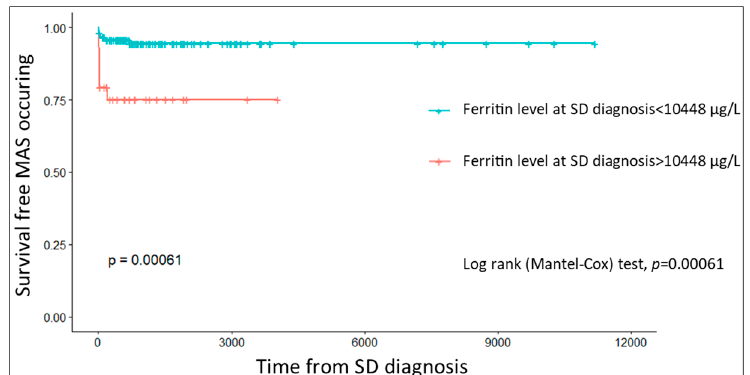
Figure 1. Kaplan–Meier curves showing the probability of MAS-free survival as a function of ferritin level at the time of SD diagnosis (MAS, macrophage activation syndrome; SD, Still’s disease).